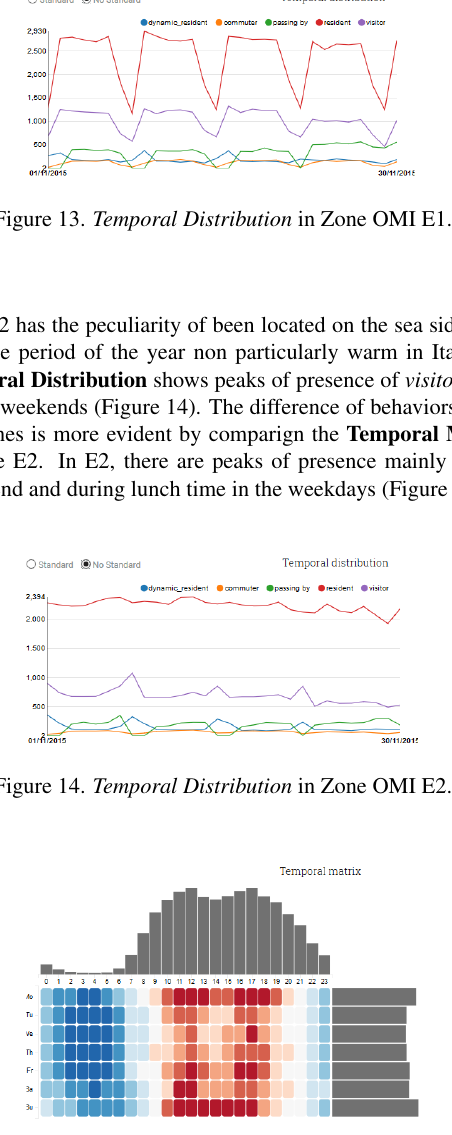
Figure 15. Temporal Matrix of Zone OMI